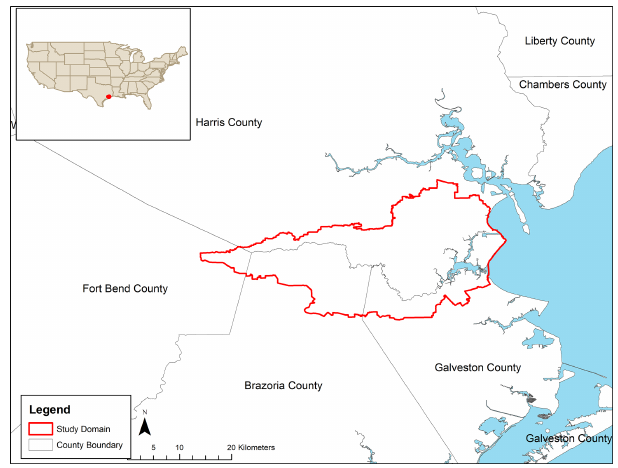
Figure 1. The Clear Creek watershed test domain for this study spans portions of four counties in Texas. Sources of the background imagery include Esri, TomTom, the U.S. Department of Commerce, and the Census